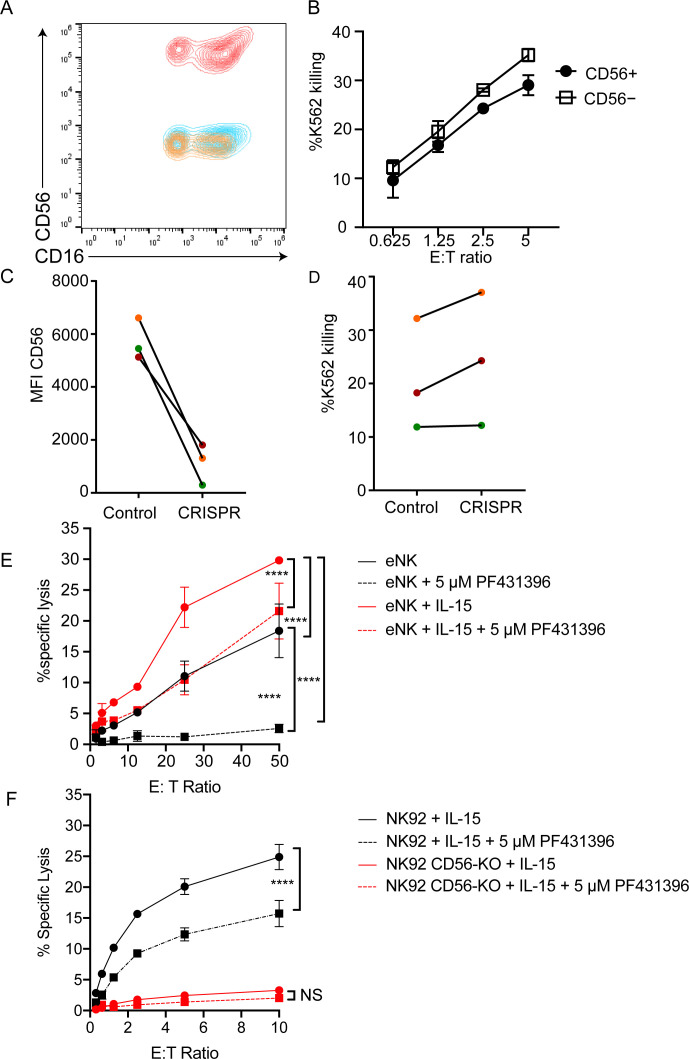
CD56-deficient primary NK cells retain lytic function.Primary NK cells were isolated and allowed to rest overnight in the presence of low-dose IL-15 prior to delivery of CD56 CRISPR-Cas9. Cells were further expanded in the presence of 25 ng/ml IL-15 for 15 days and cytotoxicity against K562 targets was measured. (A) Representative FACS plot of CD56-deficient (blue) or control primary cells (red) after 15 days of IL-15 expansion. Shown also is the fluorescence minus one control (yellow). (B) K562 target cell lysis by primary NK cells shown in (A). (C) Control or CD56-deficient NK cells from three healthy donors were incubated for 1 week after CD56 CRISPR-Cas9 delivery in 25 ng/mL IL-15 then cells were isolated by FACS and cultured for an additional 8 days and the MFI of CD56 was measured by flow cytometry. (D) Specific lysis of K562 target cells by isolated and expanded CD56bright NK cells from the three healthy donors shown in (C). (E) Primary NK cells were incubated and expanded for 14 days in the presence of 50 ng/ml IL-15 then cytotoxicity against K562 target cells was tested in the presence or absence of Pyk2 inhibitor PF431396. Freshly isolated, non-expanded NK cells were used as a control and similarly treated with PF431396. (F) WT or CD56-KO NK92 cells were incubated for 7 days in the presence of 50 ng/ml IL-15 then cytotoxicity was tested in the presence or absence of PF431396. Shown is one representative experiment from three independent biological repeats. Error bars represent 3 technical repeats, SEM.